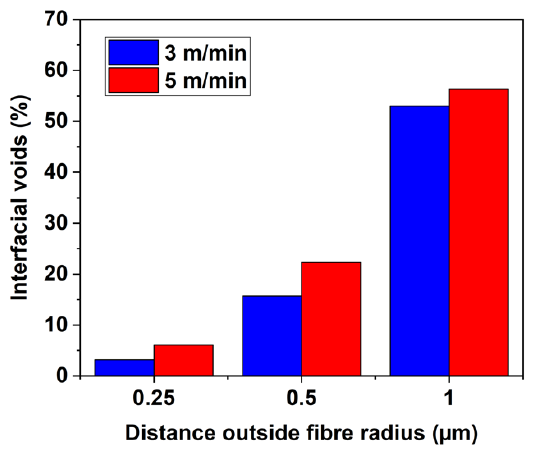
Figure 7. Percentage of interfacial voids as a fraction of the total voids.